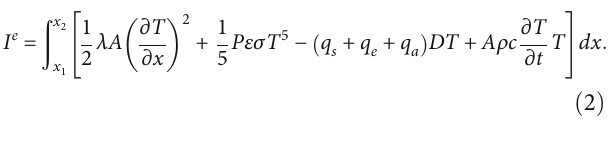
Figure 4: Three-node 2D triangle thermal